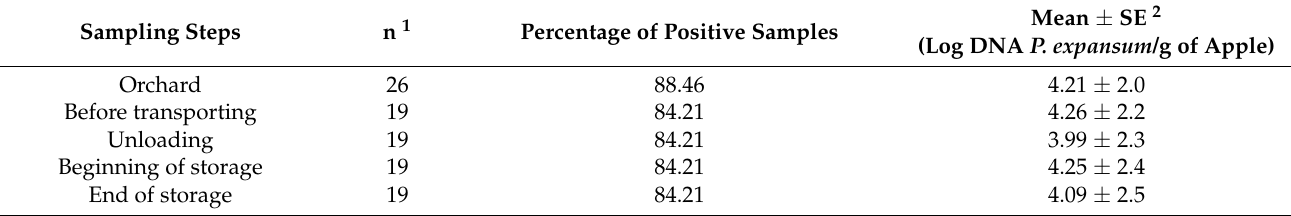
Figure 4. Boxplot illustrating the DNA amounts of P. expansum per g of apple on the surface of 225 cider-apples sampled at the orchard and at different post-harvest steps. The fungal abundance within each step was measured in three replicates by qPCR. P. expansum is present on the surface of apples at the orchard and is maintained throughout the post-harvest steps. One-way ANOVA test showed no significant difference for fungal biomass at the sampling stages. Table 3. DNA amounts of P. expansum at the surface of cider-apples picked at different post-harvest